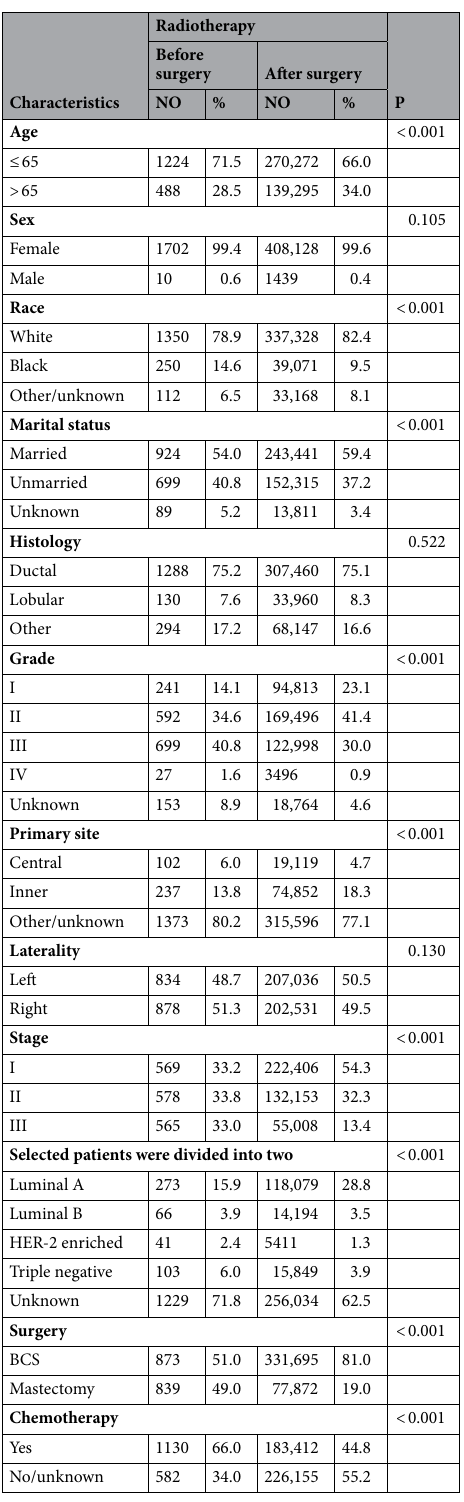
Table 1. Baseline characteristics of the preoperative and postoperative RT